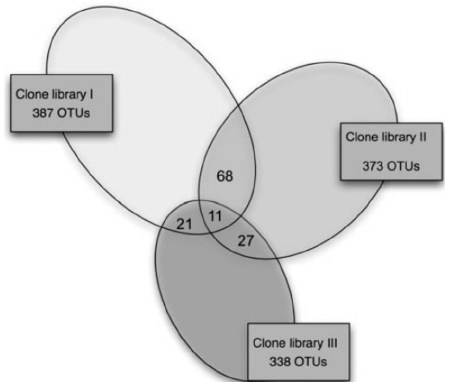
Figure 2. The overlap between Sanger sequencing results of three 16S clone libraries at 99% identity from a beach sand using two DNA extraction methods and two primer pairs. Clone library 1 Extraction method 1 PCR primer pair 1, Clone library II Extraction method 2 PCR primer pair 1, Clone library III Extraction method 1 PCR primer pair 2. Reprinted by permission from Macmillan Publishers Ltd: ISME J. [45], copyright (2009).